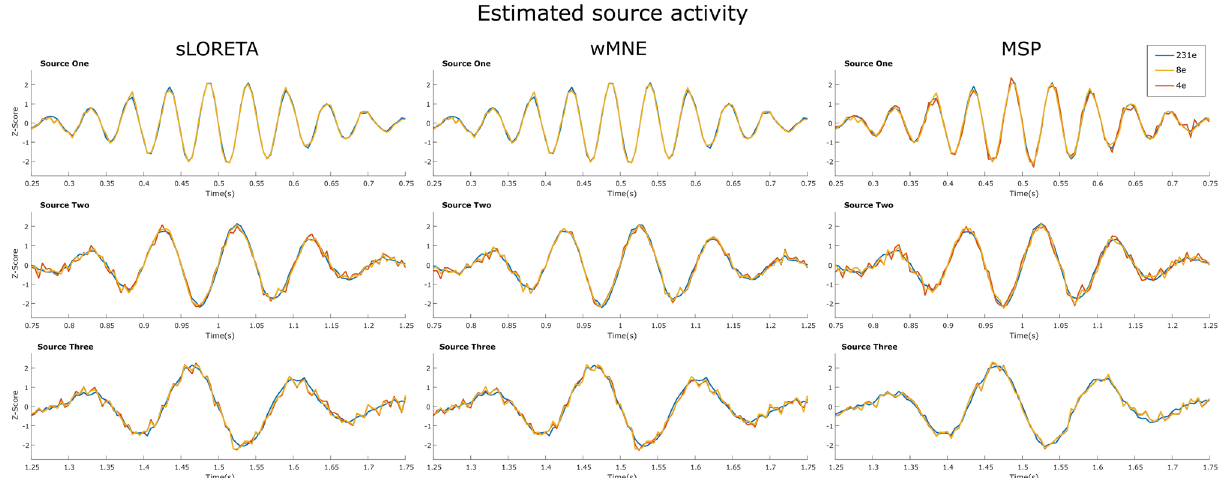
Figure 9. Example of the estimated time courses of the three sources with the full set of 231 channels, and with the optimized combinations with four and eight channels for one